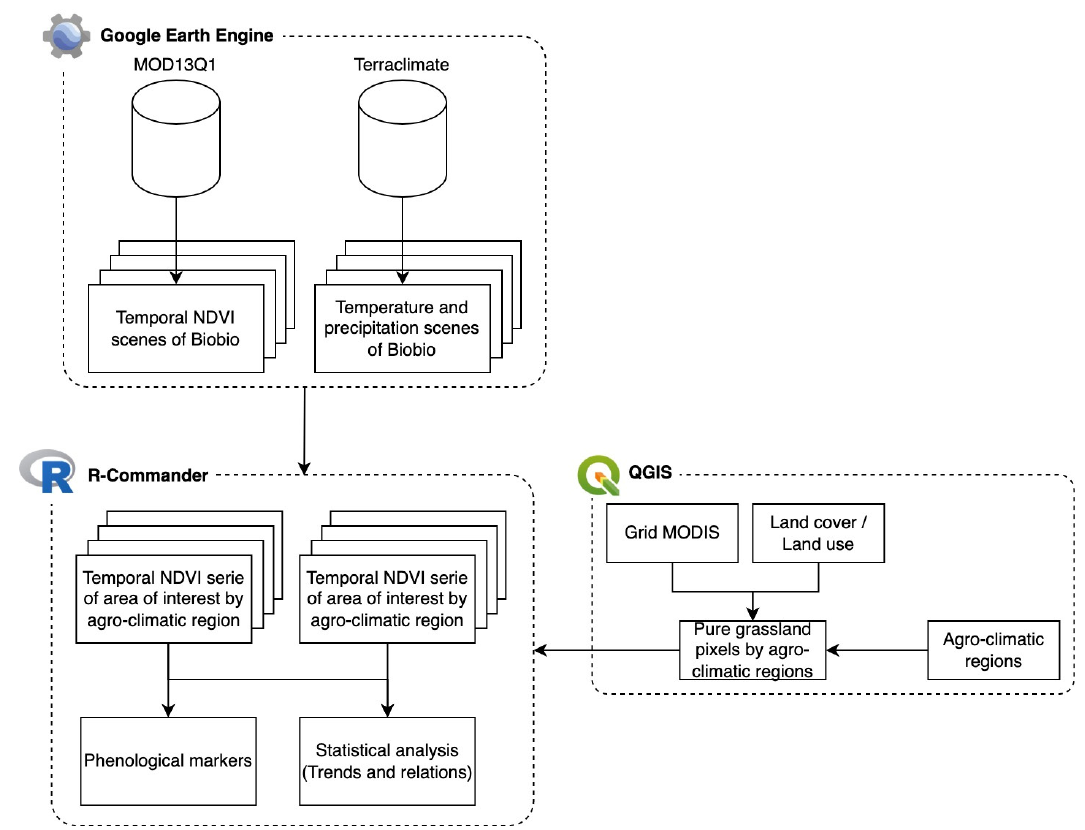
Figure 4. Flowchart describing the methodology of remote sensing and climatic data to describe phenology of grasslands in Biobio from 2001 to 2020.